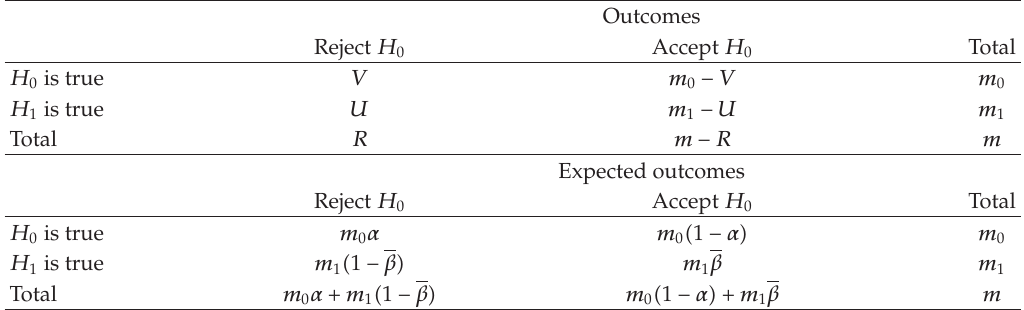
Table 1: Outcomes and expected outcomes of testing m